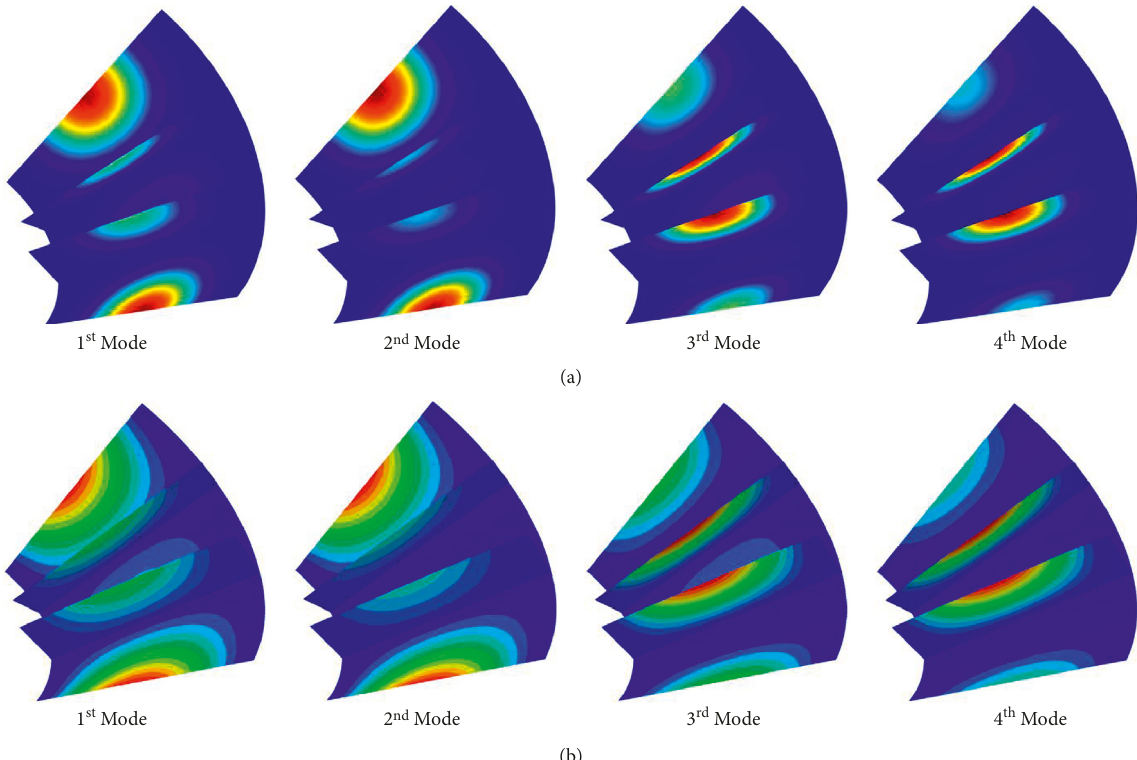
Figure 7: Mode shapes of functionally graded open conical shells with two axial bulkheads and CFCF boundary condition ( α � 30 ° ): (a) present and (b) ABAQUS.